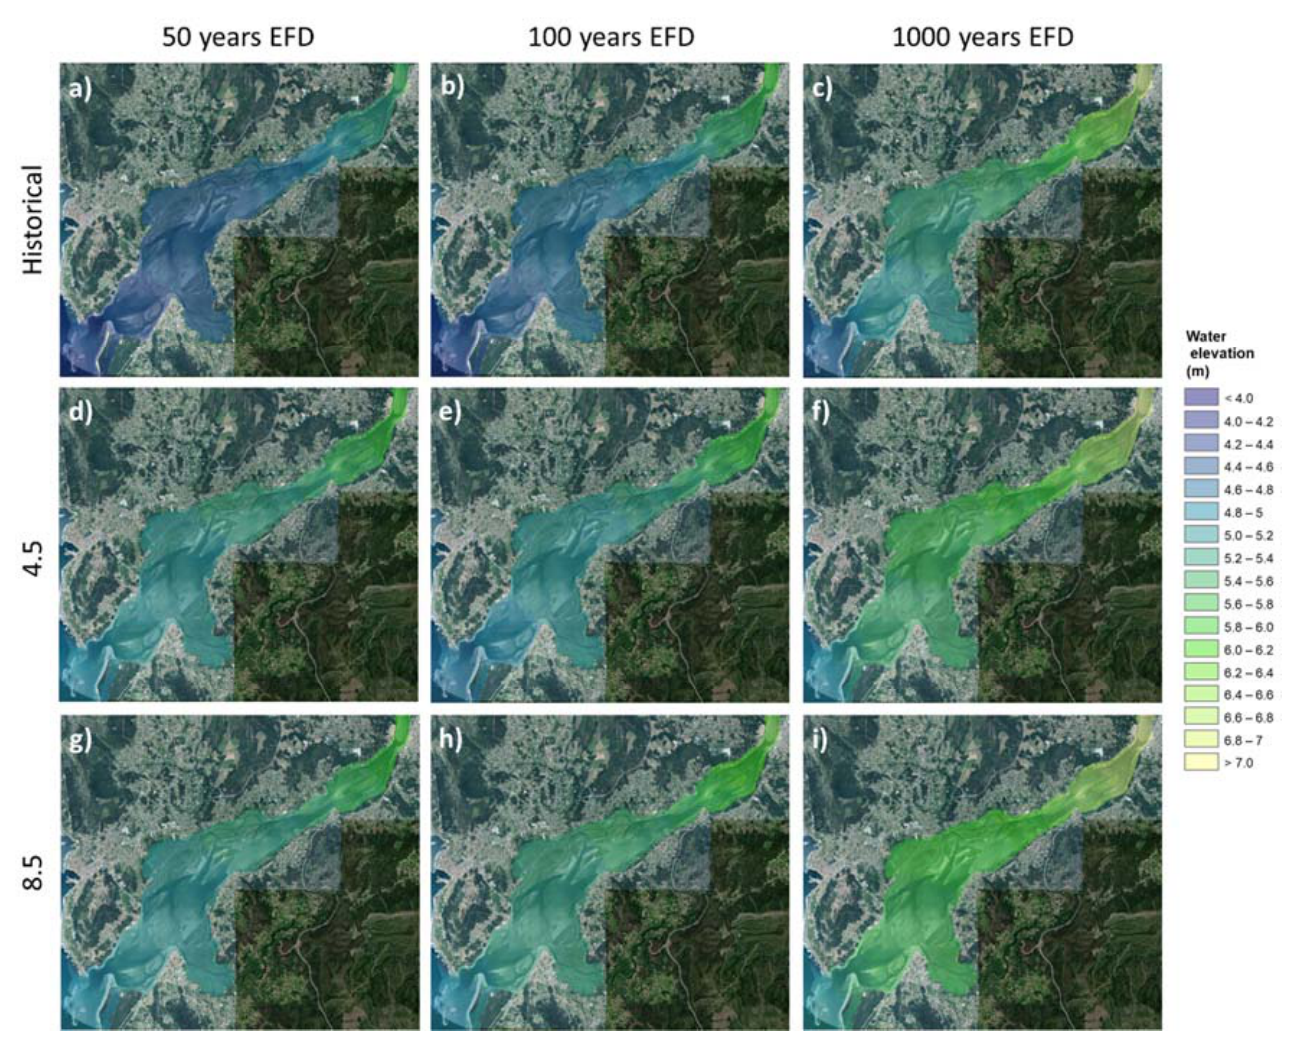
Figure 5. Water levels in the Minho estuary forecasted for the ( a ) S1 scenario (historical, 50-year EFD return period), ( b ) S14 scenario (historical, 100-year return EFD period), ( c ) S27 scenario (historical, 1000-year EFD return period), ( d ) S5 (4.5, 50-year EFD return period), ( e ) S18 (4.5, 100-year EFD return period), ( f ) S31 (4.5, 1000-year EFD return period), ( g ) S11 (8.5, 50-year return EFD period), ( h ) S24 (8.5, 100-year EFD return period), and ( i ) S37 (8.5, 1000-year EFD return period) (base map sources: Esri, Maxar, GeoEye, Earthstar Geographics, CNES/Airbus DS, USDA, USGS, AeroGRID, IGN, and the GIS User Community).